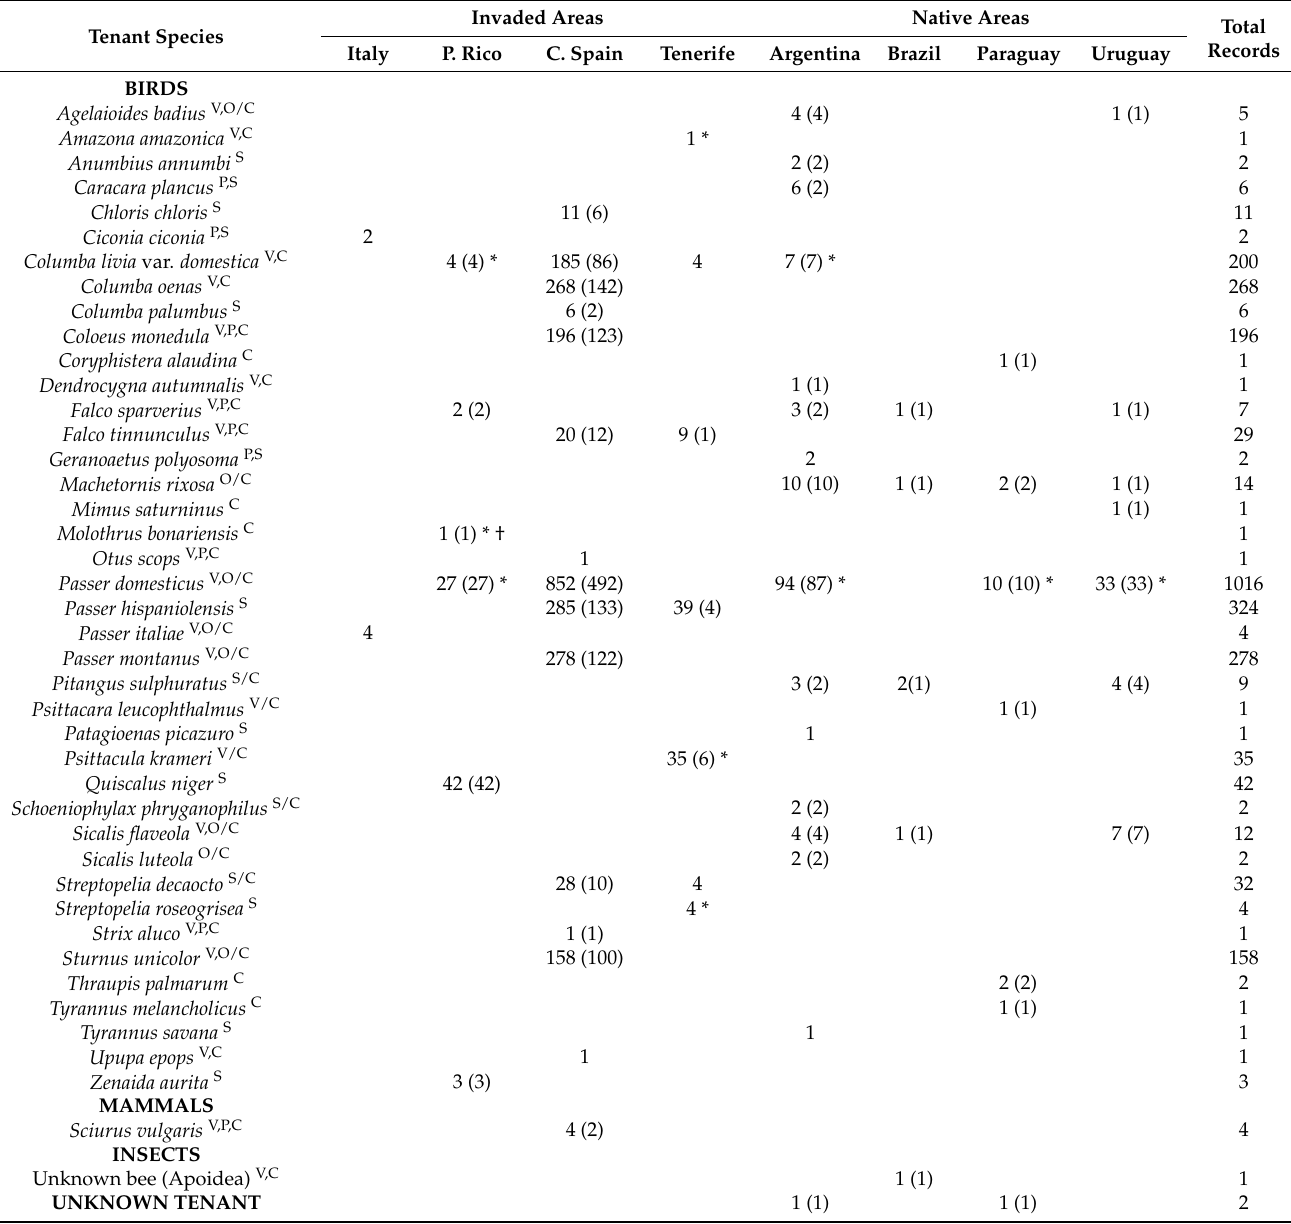
Table 1. List of recorded tenant species and their number of nesting pairs present in monk parakeet nests in the native (South America: Argentina, Brazil, Paraguay, Uruguay) and invaded (Italy, Puerto Rico, Continental Spain, Tenerife) ranges of monk parakeets. The number of recorded tenant nests used in GLMs (shown in Table 2) are in parentheses. Invaded Tenant Species